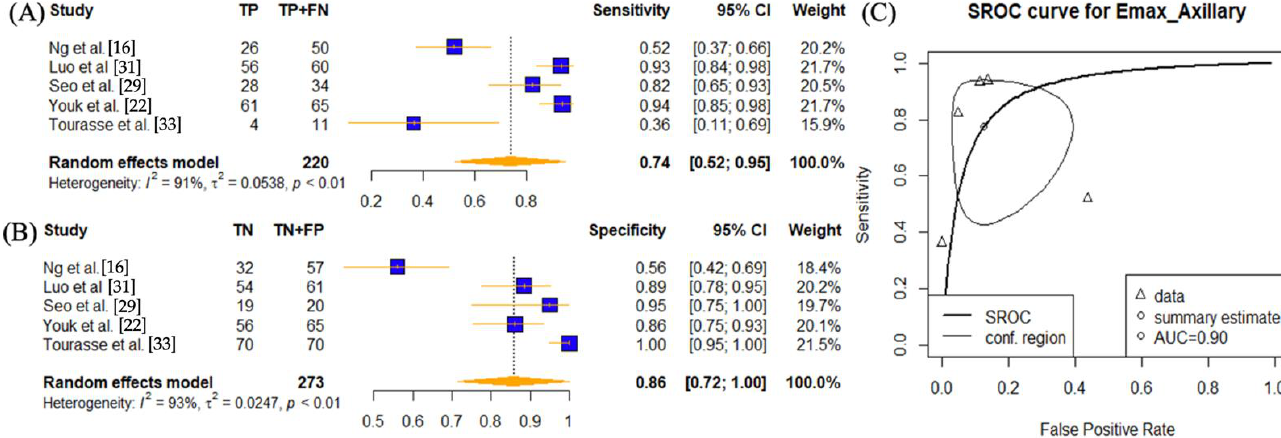
Figure 6. Sensitivity and specificity forest plots and overall accuracy results of E max in Axillary LNs. ((A-C) Reported sensitivity and specificity values for E max values per selected study with AUC value on SROC curve for the analysis of E max . Forest plots for pooled sensitivities and specificities are displayed as diamonds in the graphs for E max ( A , B ). The SROC curve indicates the summary estimates in circles (( C ) for E max ). Triangles represent included study with dotted lines representing the confidence interval and solid line for the SROC. AUC value is displayed (in the legend). E max — maximum tissue stiffness SWE parameter; AUC — area under the curve; SROC — summary receiver operating characteristic.